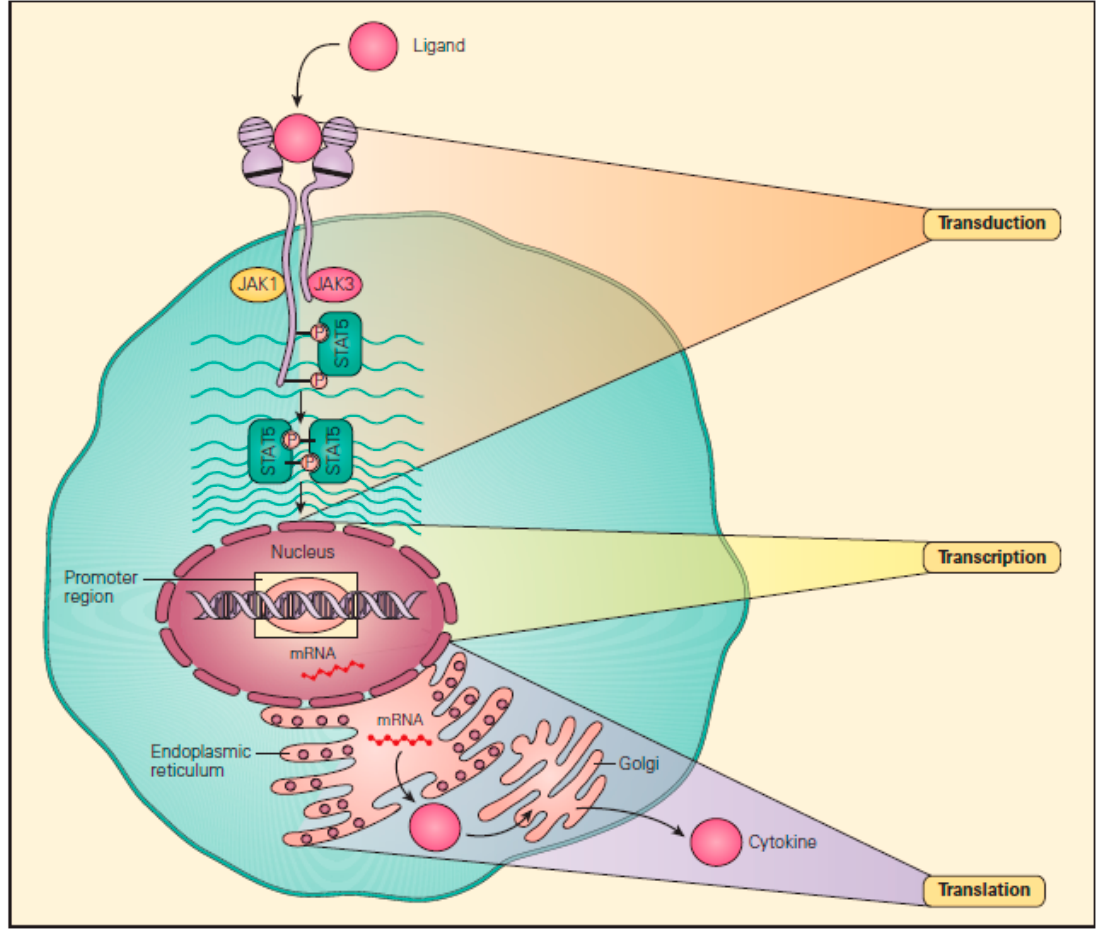
Figure 2. Transduction, transcription, and translation (the “three Ts”). These are the three steps in signaling pathways involved in protein synthesis, beginning with the binding of a ligand with a cell surface receptor initiating the first “T,” transduction, i.e., to lead across. This then proceeds to the phosphorylation of a number of cascading substrate molecules by kinases (i.e., phosphorylases) that results in the production of a transcription factor that binds to a promoter region of DNA within the nucleus. This then initiates the second “T,” transcription, i.e., to write across, during which messenger RNA (mRNA) is formed. After leaving the nucleus, the mRNA sits on a ribosome within the endoplasmic reticulum and acts as a “blueprint” to initiate the third “T,” translation, i.e., to carry across, culminating in the assembly of amino acids into a final protein. (Reproduced with permission from Bellanti, J.A. Immunology IV: Clinical Applications in Health and Disease . I Care Press: Bethesda, MD, USA, 2012) [8]